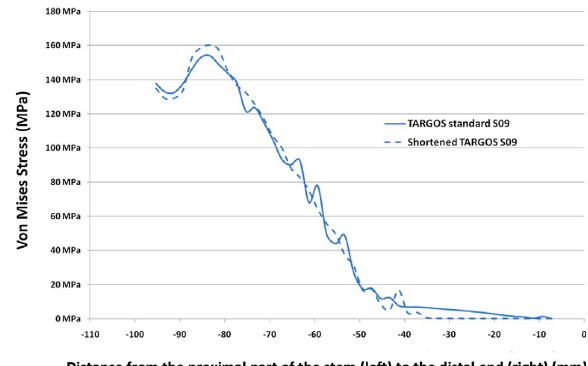
Figure 3. Comparison of Von Mises stress values on the external line of the stem with a standard stem and a shortened stem ( (cid:1) 40 mm).